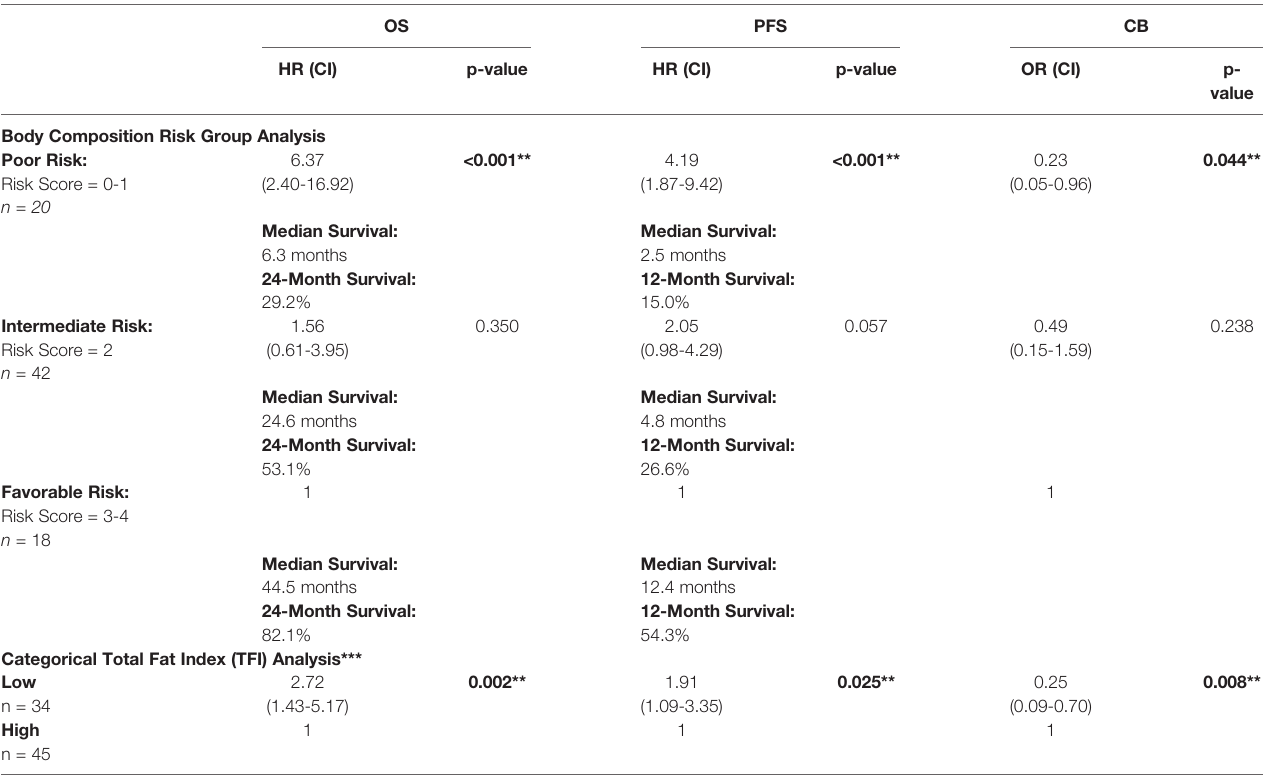
TABLE 2 | MVA* of association between body composition risk groups and TFI with clinical